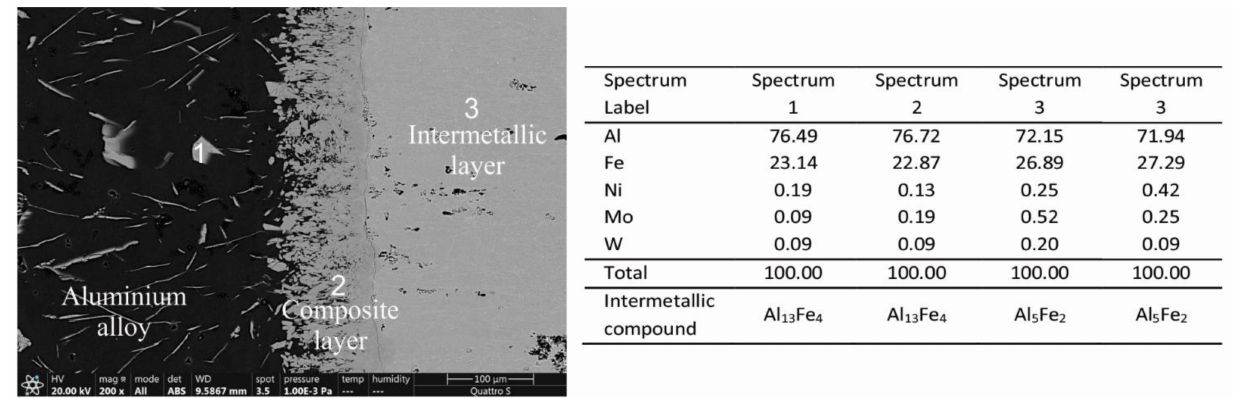
Figure 4. SEM micrographs of the interaction layer of the W600 sample tested at 700 ◦ C in Al99.7 aluminum alloy. The corresponding EDS results are presented in at %. Table 3. EDS results of the carbides shown in Figure 7, presented in at %.